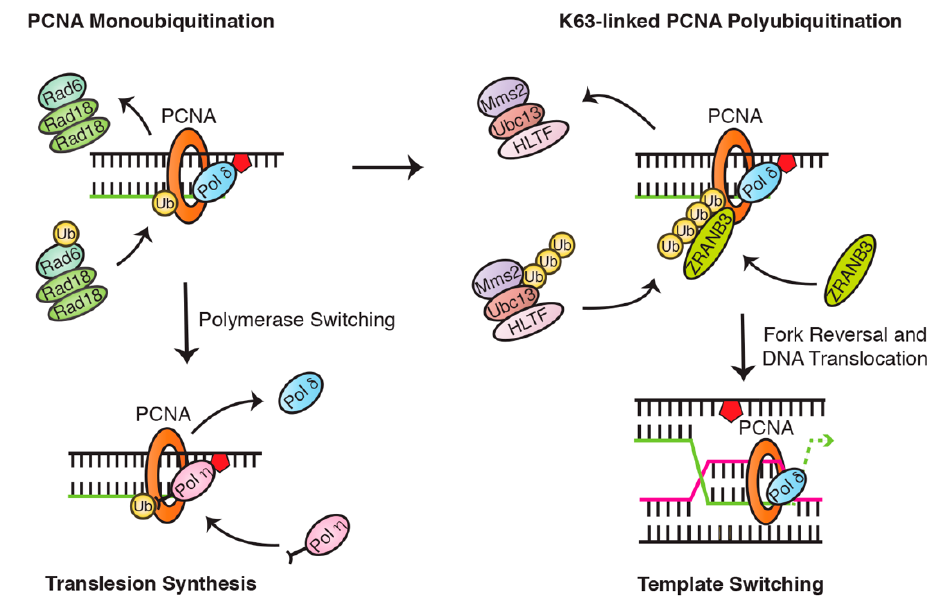
Figure 4. Mono- and polyubiquitination of proliferating cell nuclear antigen (PCNA) tightly regulates the initiation of translesion synthesis and template switching. In humans, PCNA is monoubiquitinated by the Rad6/Rad18 complex and can be subsequently polyubiquitinated by the Ubc13/Mms2/HLTF complex.